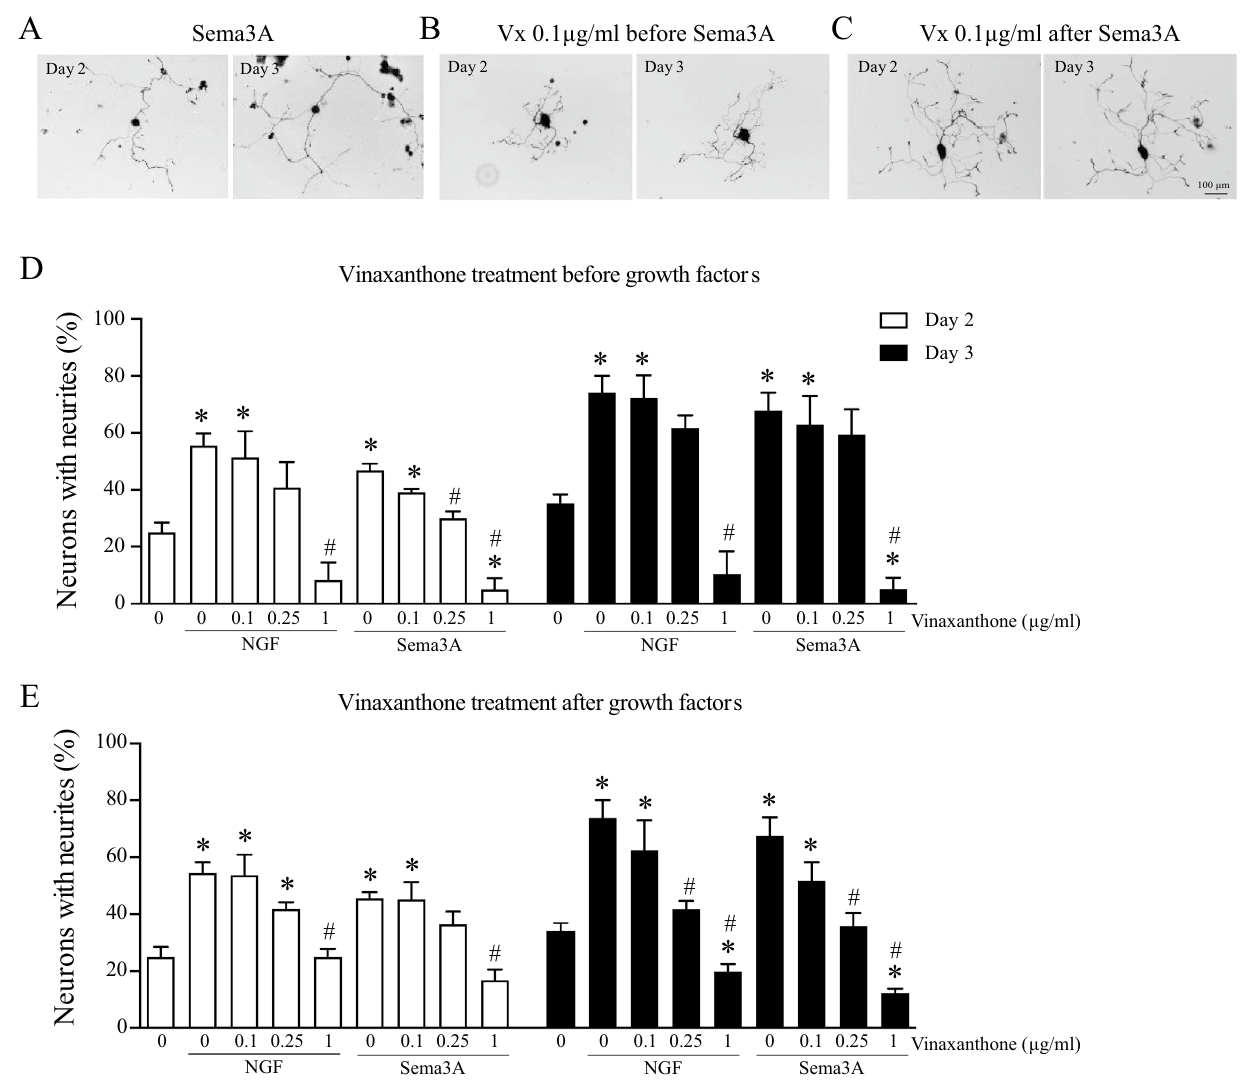
Figure 4. Vinaxanthone at its IC50 fails to inhibit the growth promoting effects of both Sema3A and NGF in adult TG neurons. Isolated TG neurons were left untreated or treated with Vinaxanthone in a concentration- dependent manner before or after incubation with NGF or Sema3A. Representative images of neurite growth induced by Sema3A ( A ) and the effects of 0.1 μg/mL Vinaxanthone added before ( B ) or after Sema3A ( C ), the images shown correspond to the same neurons imaged on Day 2 and Day 3 for each treatment, respectively. ( D ) The neurons were pre-treated with different doses of Vinaxanthone for 1 h. Then, NGF or Sema3A at 50 ng/mL were added to the dishes and neuronal growth was evaluated on Days 2 and 3 of culture. Vinaxanthone used at its IC50 of 0.1 μg/mL does not inhibit the Sema3A or NGF induced neurite growth. At the highest tested dose, Vx pre-treatment led to a level of neurite formation that was significantly below the level seen in either the NGF or Sema3A treated conditions. ( E ) Neurons were treated with 50 ng/mL NGF or Sema3A and allowed to grow for 1 day, at which point the medium was replaced with new medium containing different doses of Vinaxanthone. After additional 24 and 48 h of culture, neurons were evaluated for neuronal growth, and we found a similar trend for neurite formation as demonstrated for the Vx pre-treatment condition. Data represent the mean ± SEM of four independent experiments, a P value < 0.05 was considered statistically significant between the treatments ( # statistically significant treatment vs NGF or Sema3A alone, respectively; *statistically significant treatment vs control), all images at same magnification, scale bar = 100